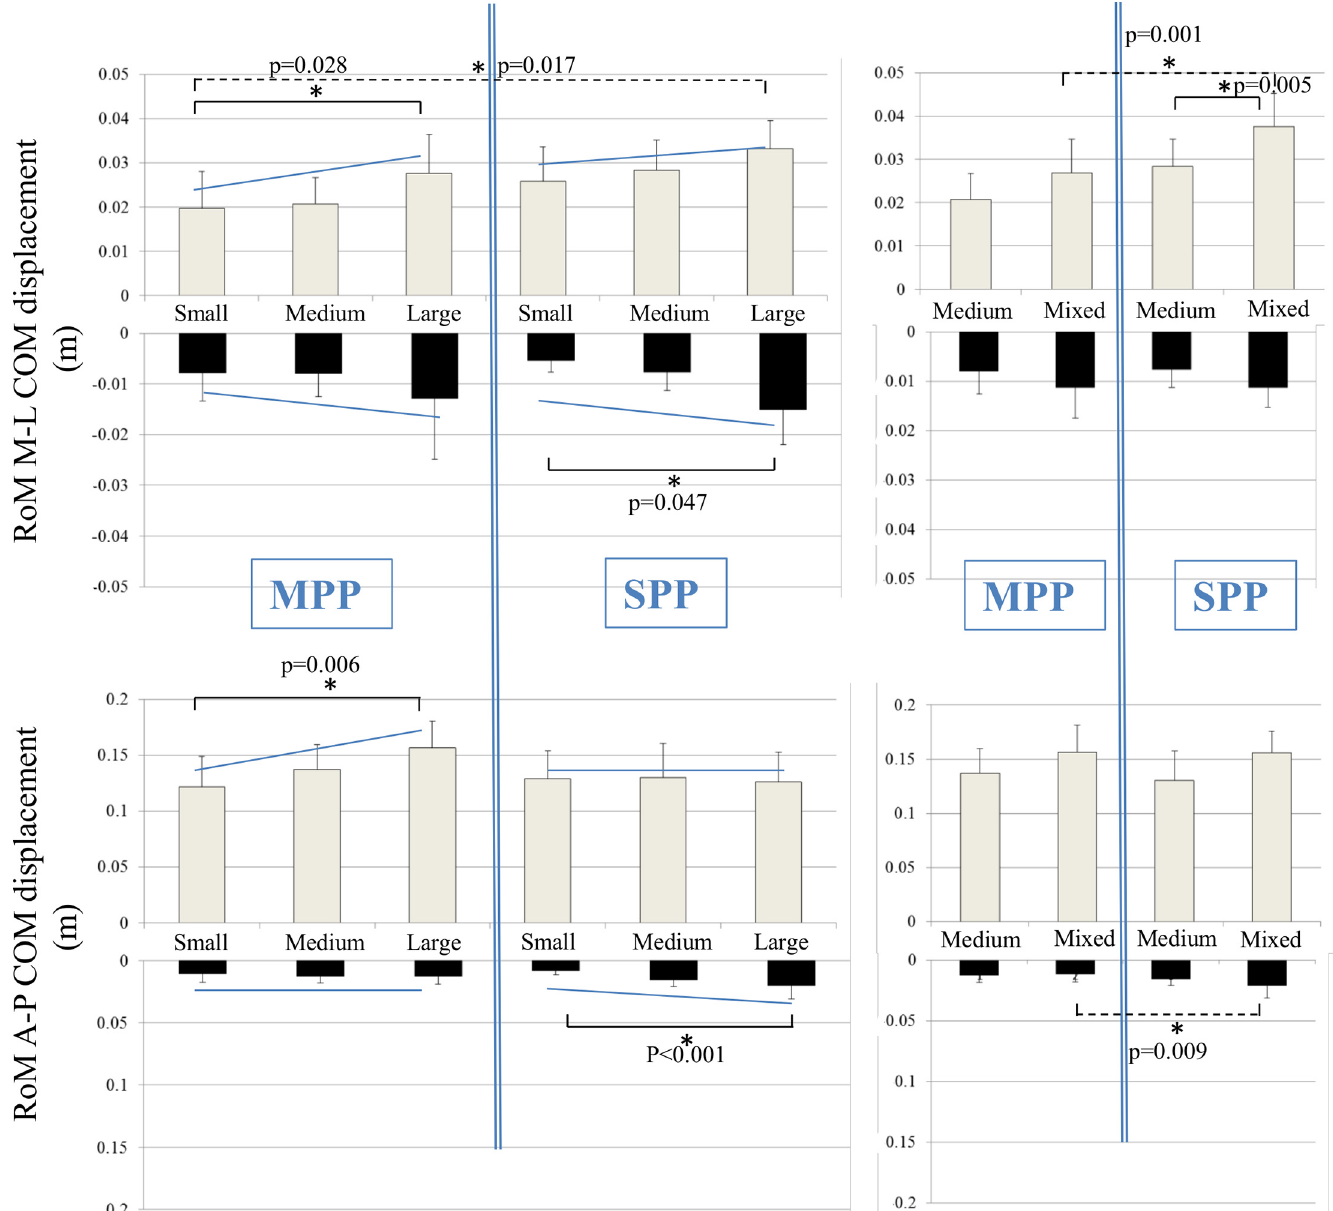
Fig 5. Visualisation of the average medio-lateral and antero-posterior centre of mass (COM) displacement. The light colored bars represent the perturbation phase while the dark colored bars represent the response phase. Post-hoc Bonferroni tests revealed significant differences between conditions and are highlighted with an asterisk (p <